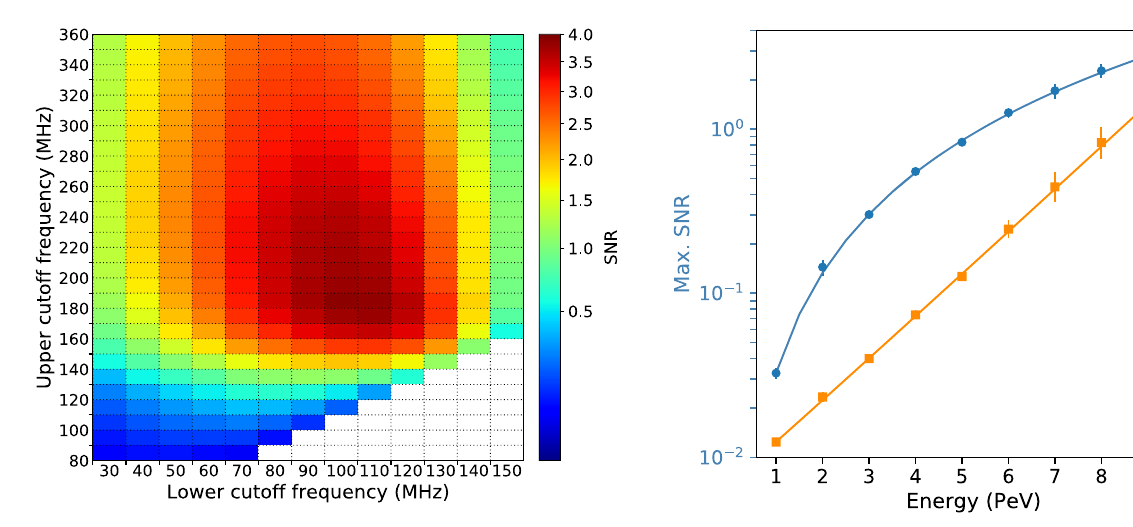
Fig. 3 An updated version of the plot showing the evolution of the maximum SNR and maximum amplitude with energy (Figure 9 in [1])